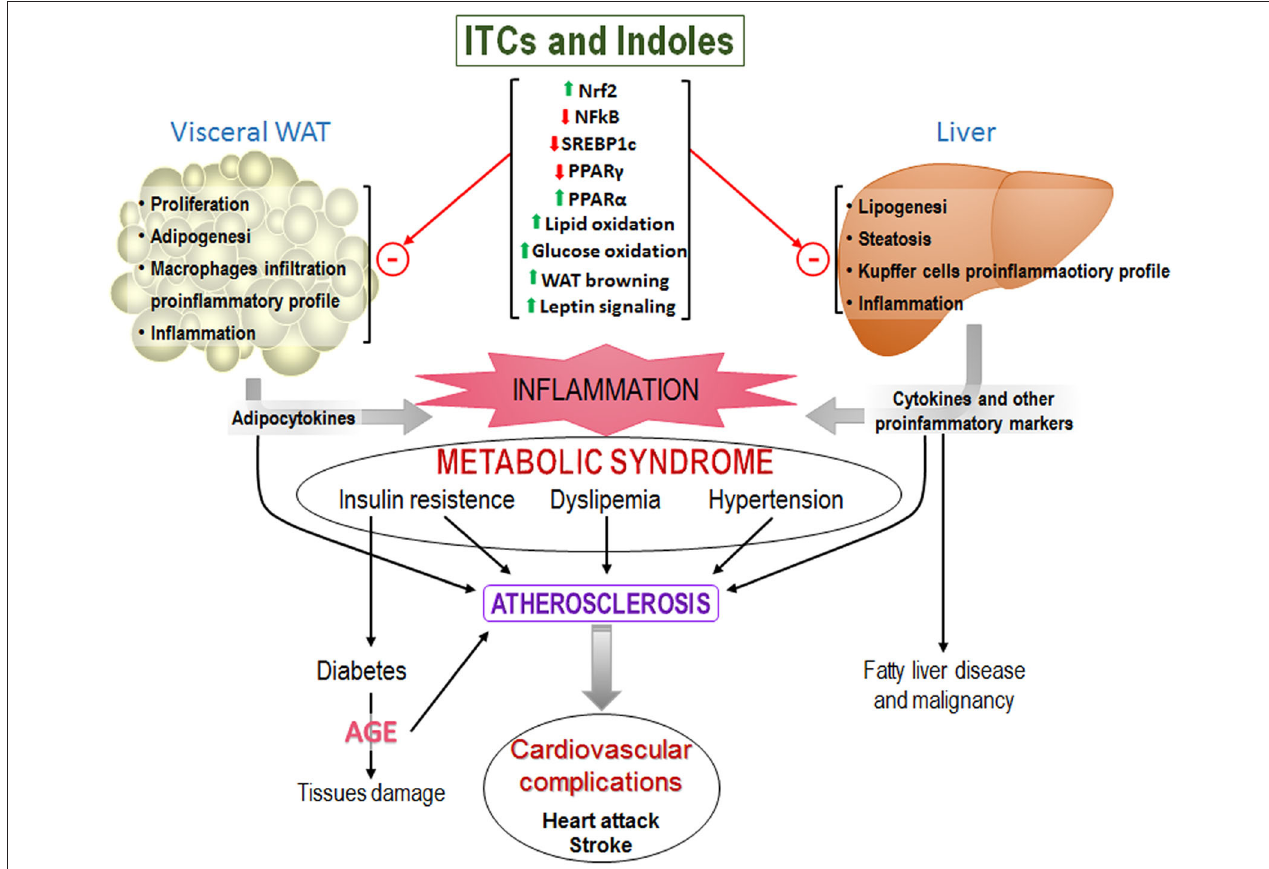
FIGURE 5 | Representative scheme of the main components of the MetS that ultimately lead to cardiovascular problems and others. Upper of the figure are shown the effects of isothiocyanates that have been found and that could prevent MetS